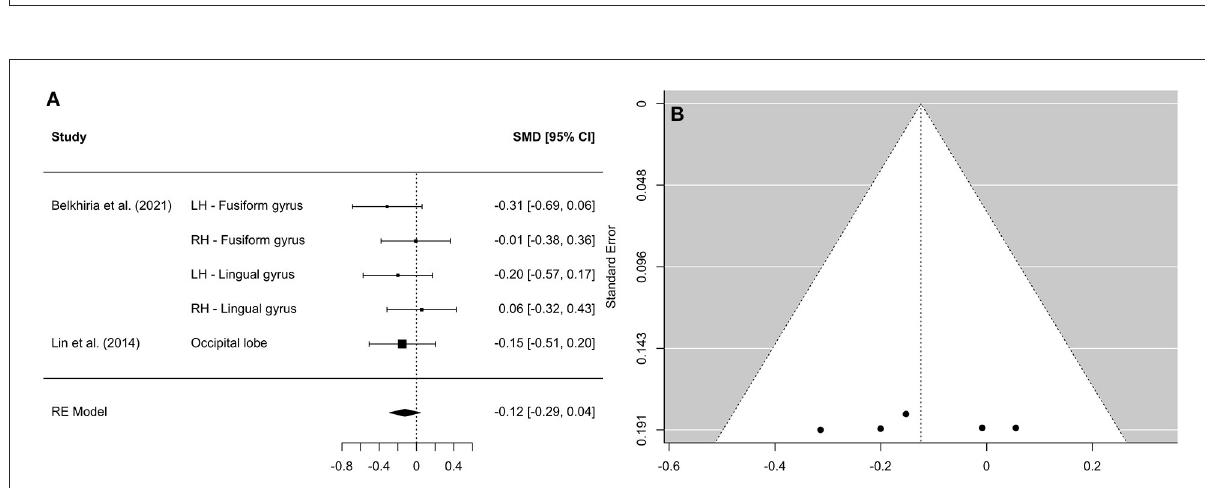
FIGURE6 Forest plot (A) and funnel plot (B) of the occipital lobe analysis. In the forest plot (A) negative values on the x-axis indicate gray matter